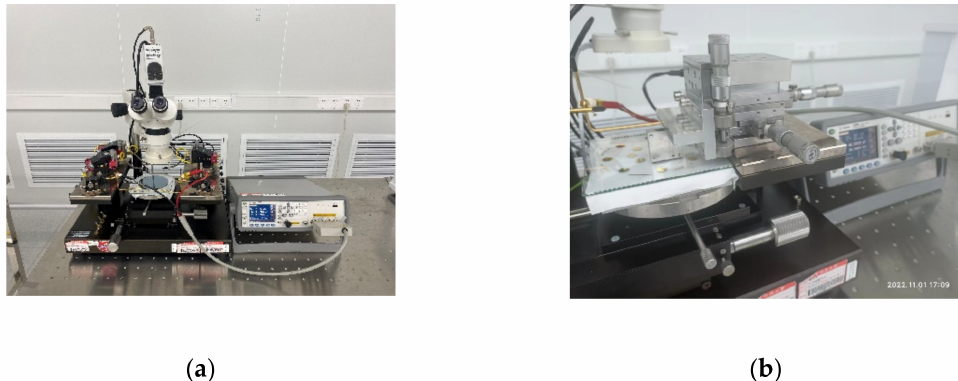
Figure 7. Experimental sets, ( a ) the experimental sets for measuring the surface profile of wafers; ( b ) the experimental sets for calibrating the capacitive spacing transducer.